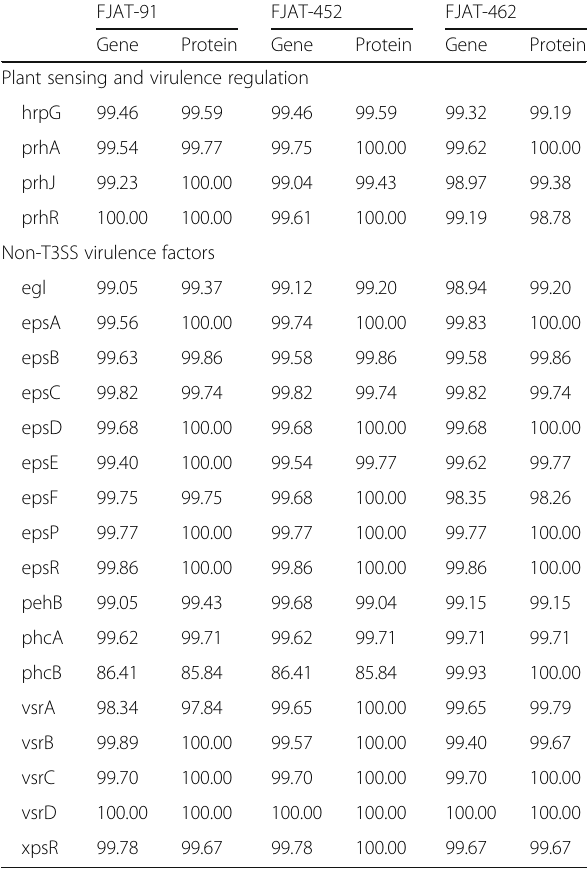
Table 7 Sequence similarity of genes involved in R.